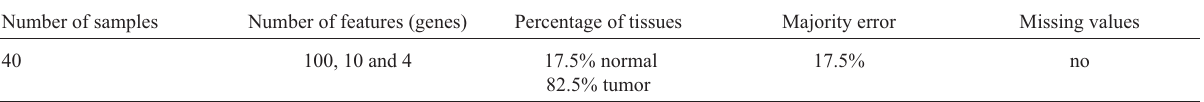
Table 2 - Description of the data sets characteristics. Number of